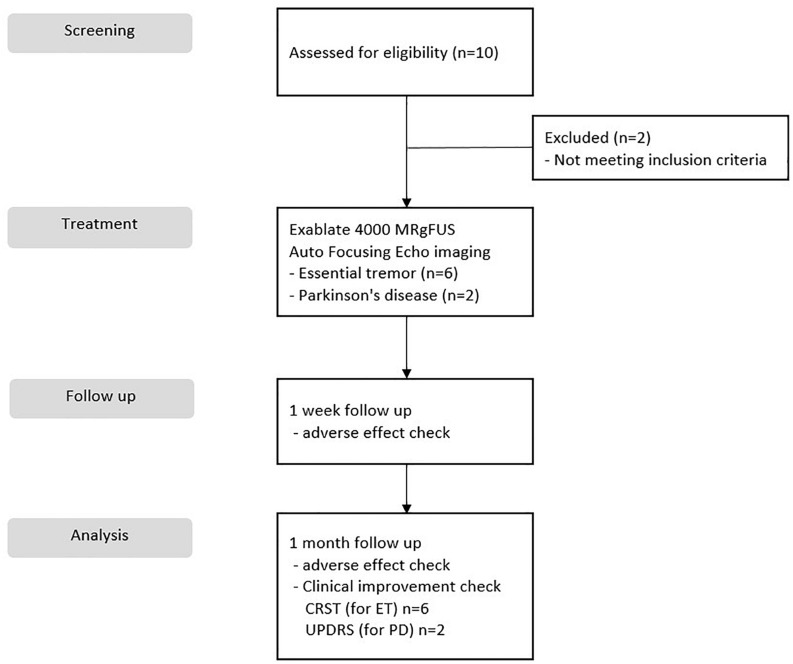
CONSORT flow diagram of patients for the study.